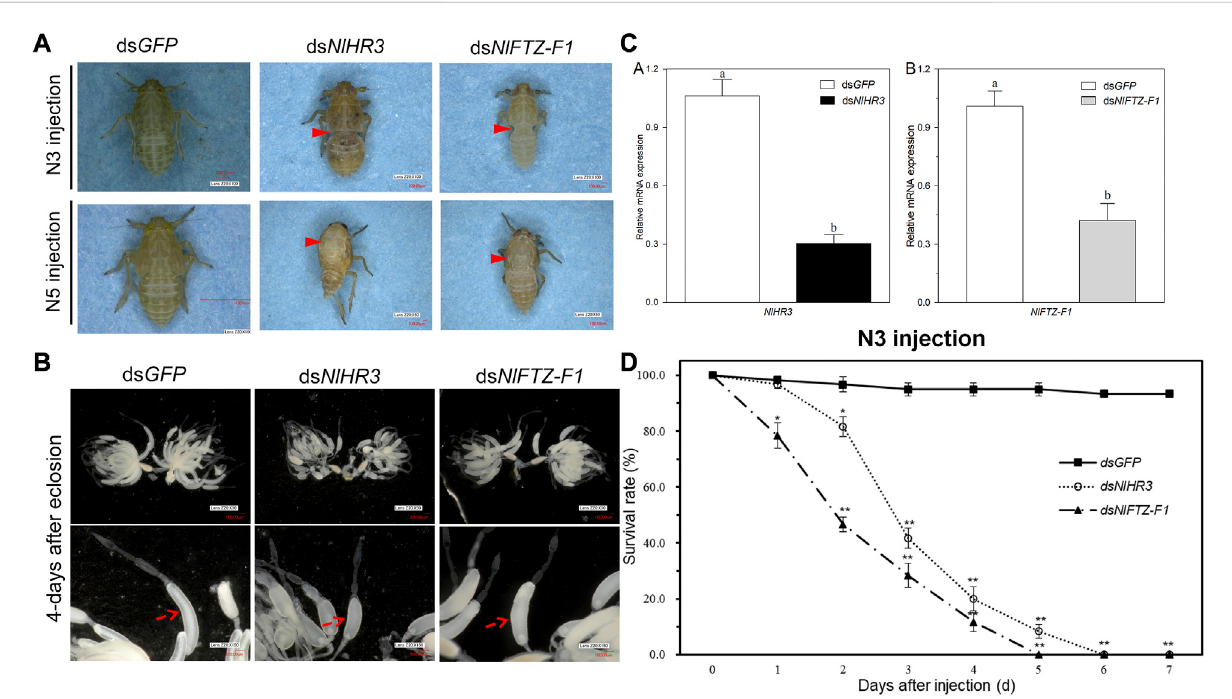
FIGURE 4 Phenotypes and the survival rate of N. lugens subjected to ds NlHR3 and ds NlFTZ-F1 injection. (A) Abnormal appearance of the phenotype of N. lugens subjected to ds NlHR3 and ds NlFTZ-F1 injection. (B) Abnormal appearance of the ovary phenotype of N. lugens subjected to ds NlHR3 and ds NlFTZ-F1 injection. (C) Relative expression level of NlHR3 and NlFTZ-F1 subjected to ds NlHR3 and ds NlFTZ-F1 injection in the third instar nymphs. (D) Survivalrate of N.lugens subjectedto ds NlHR3 andds NlFTZ-F1 injectioninthethirdinstar nymphs.The SE wasdetermined fromthreeindependent biological replicates, each with threetechnical replications. Differentlettersindicate asigni fi cant difference at a p -value < 0.05(Student ’ s t -test). *and ** indicate a signi fi cant difference at a p -value < 0.05 or < 0.01 (Student ’ s t